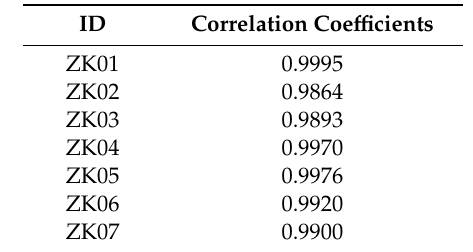
Table 2. Correlation coe ffi cients between reservoir water level and groundwater level in limestone.